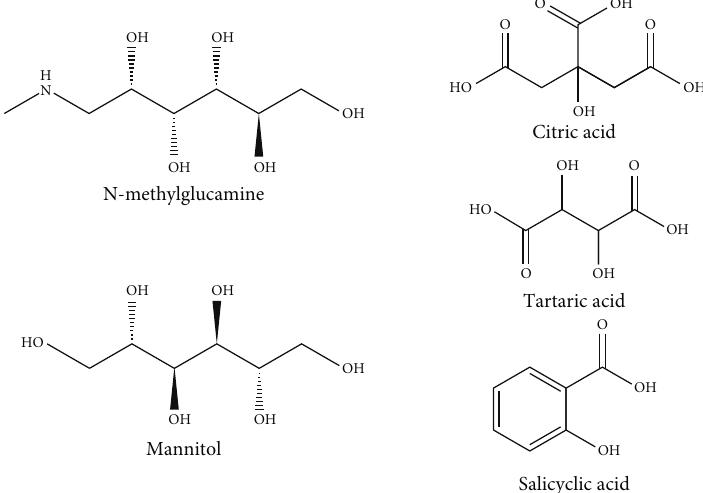
Figure 3: Structure of impregnating agent (ME, MA, CA, TA, and SA).